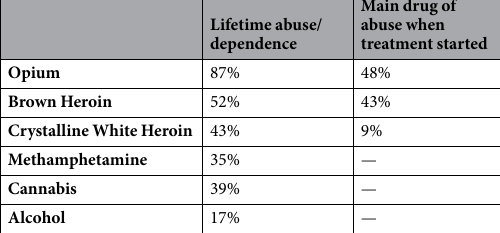
Table 4. Self-reported drug use history of